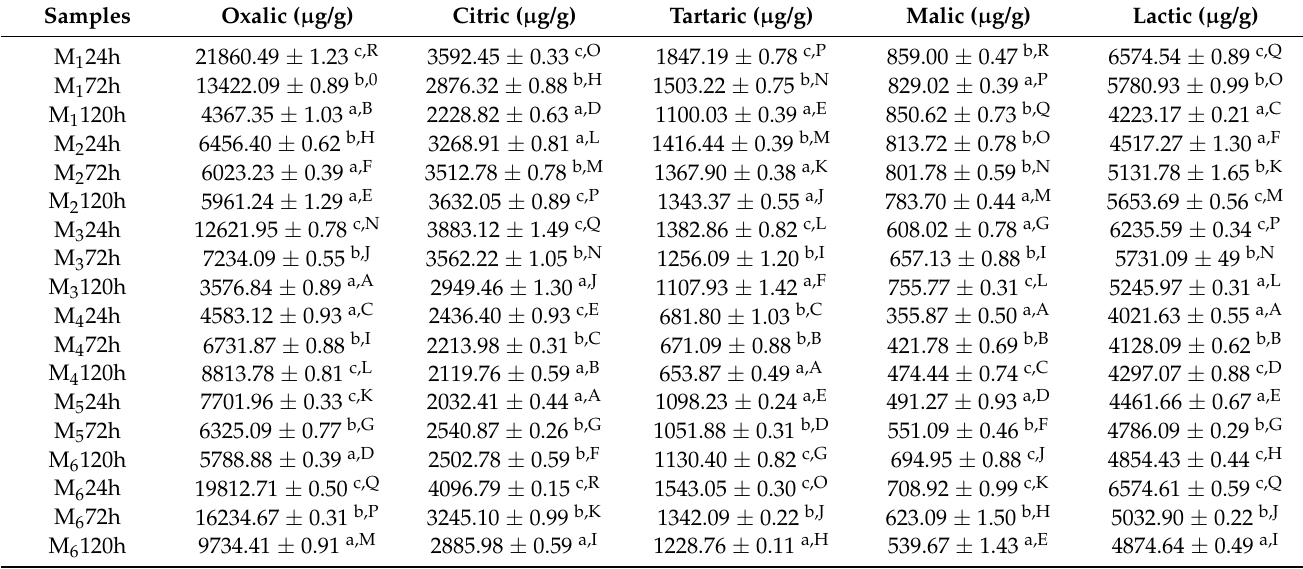
Table 6. Organic marinated acids